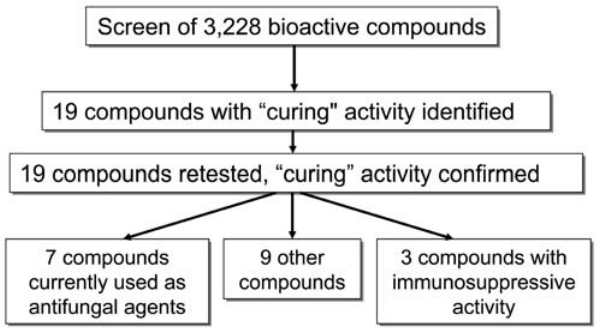
Figure 3. Flow chart representing the C.elegans ‘‘curing’’ assay that identified 19 effective